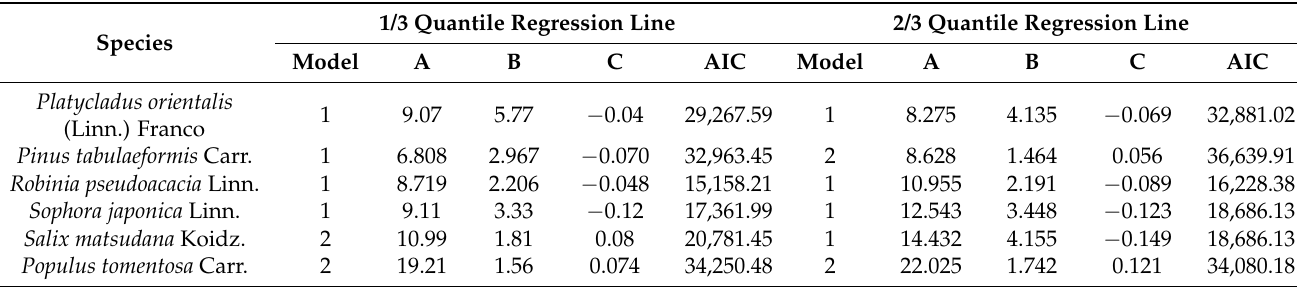
Table 5. The estimated parameters and evaluated statistics of models.